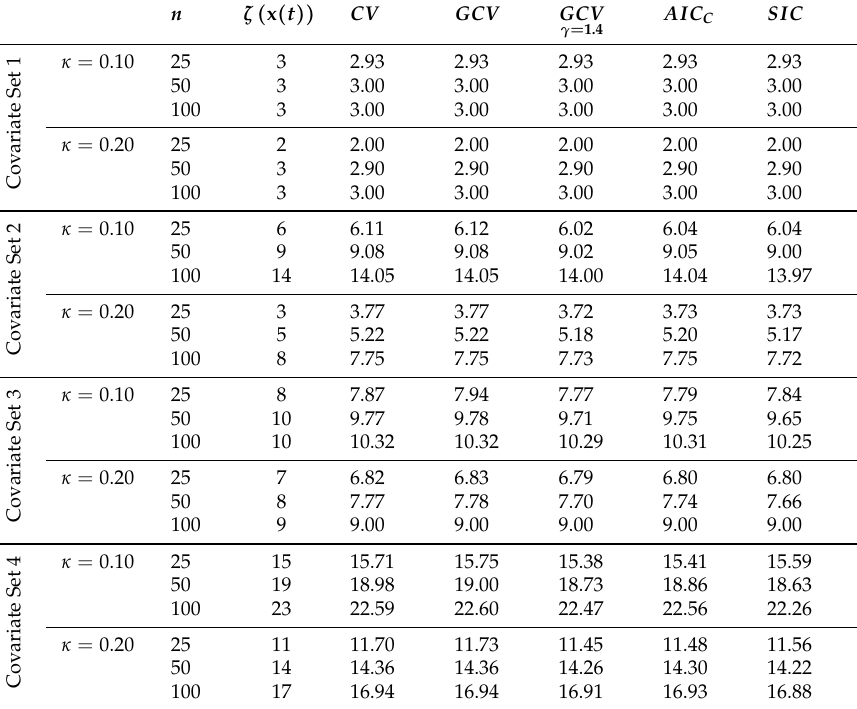
Table 7. Analogous to Table 5 for parameter curve β 3 ( t )